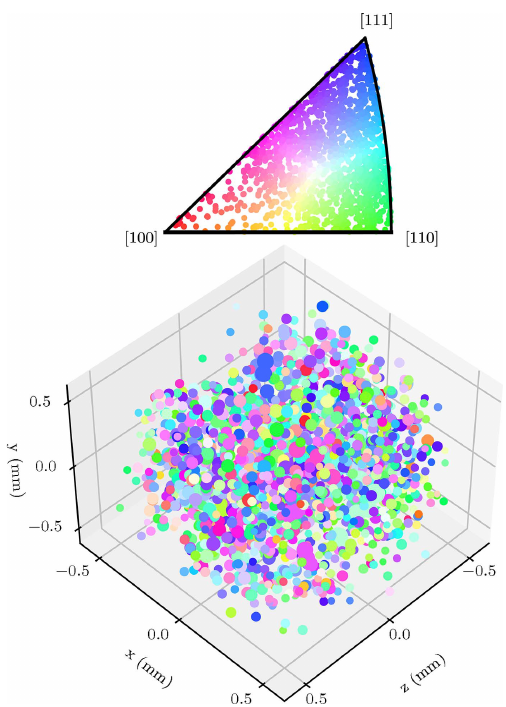
Figure 6 Stitched grain centre-of-mass map of DX54 steel (bottom) with grains coloured by their orientations as per the inverse pole figure (top) relative to the y axis.